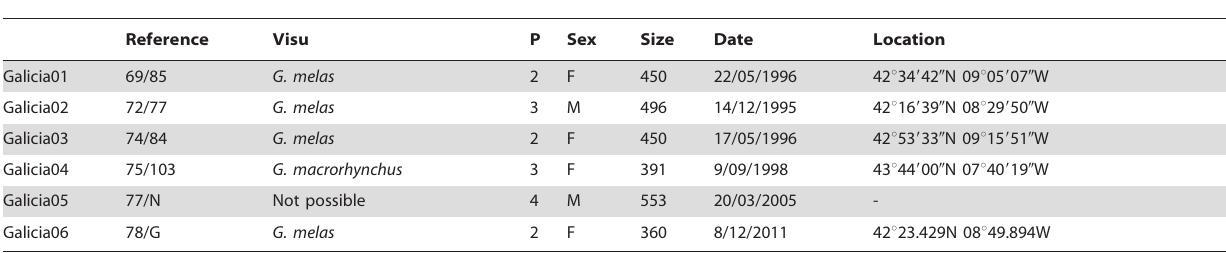
Table 1. Stranded pilot whale samples